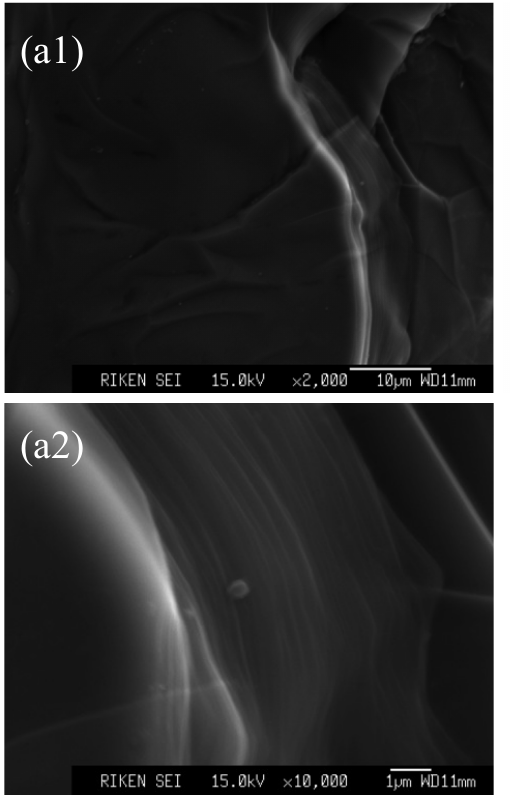
Fig. 3a. SEM images of the GS surface edge taken from above. (a1) and (a2): no-irradiated part.